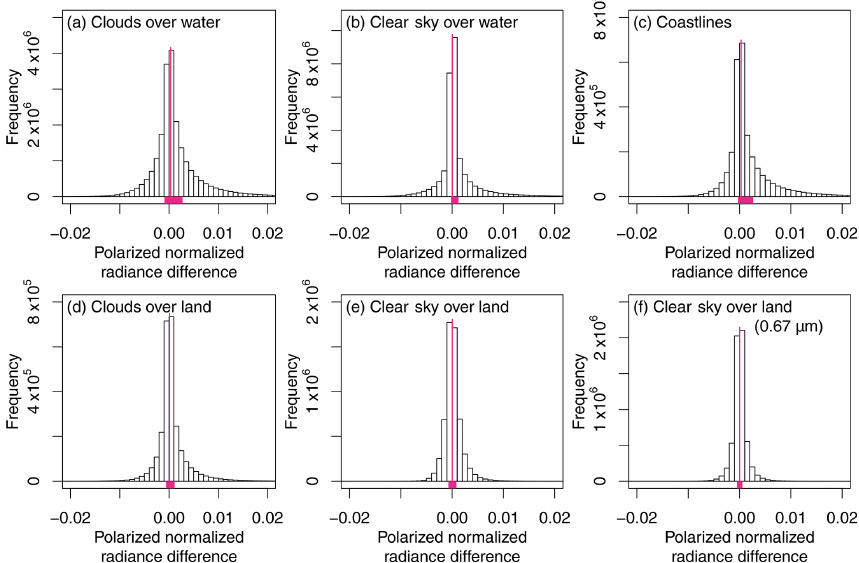
Figure 5. Histograms of proxy–reference differences in polarized normalized radiance ( L p ) for (a) clouds over water, (b) clear sky over water, (c) coastlines, (d) clouds over land, (e) clear sky over land, and (f) clear sky over land at 0.674µm. Except for (f) , the wavelength is at 0.869µm. The vertical magenta line indicates the location of the median, and the magenta bar at the bottom indicates the interquartile range. Table 5. Tests for the cloud detection algorithm over land. The symbols are the same as in Table